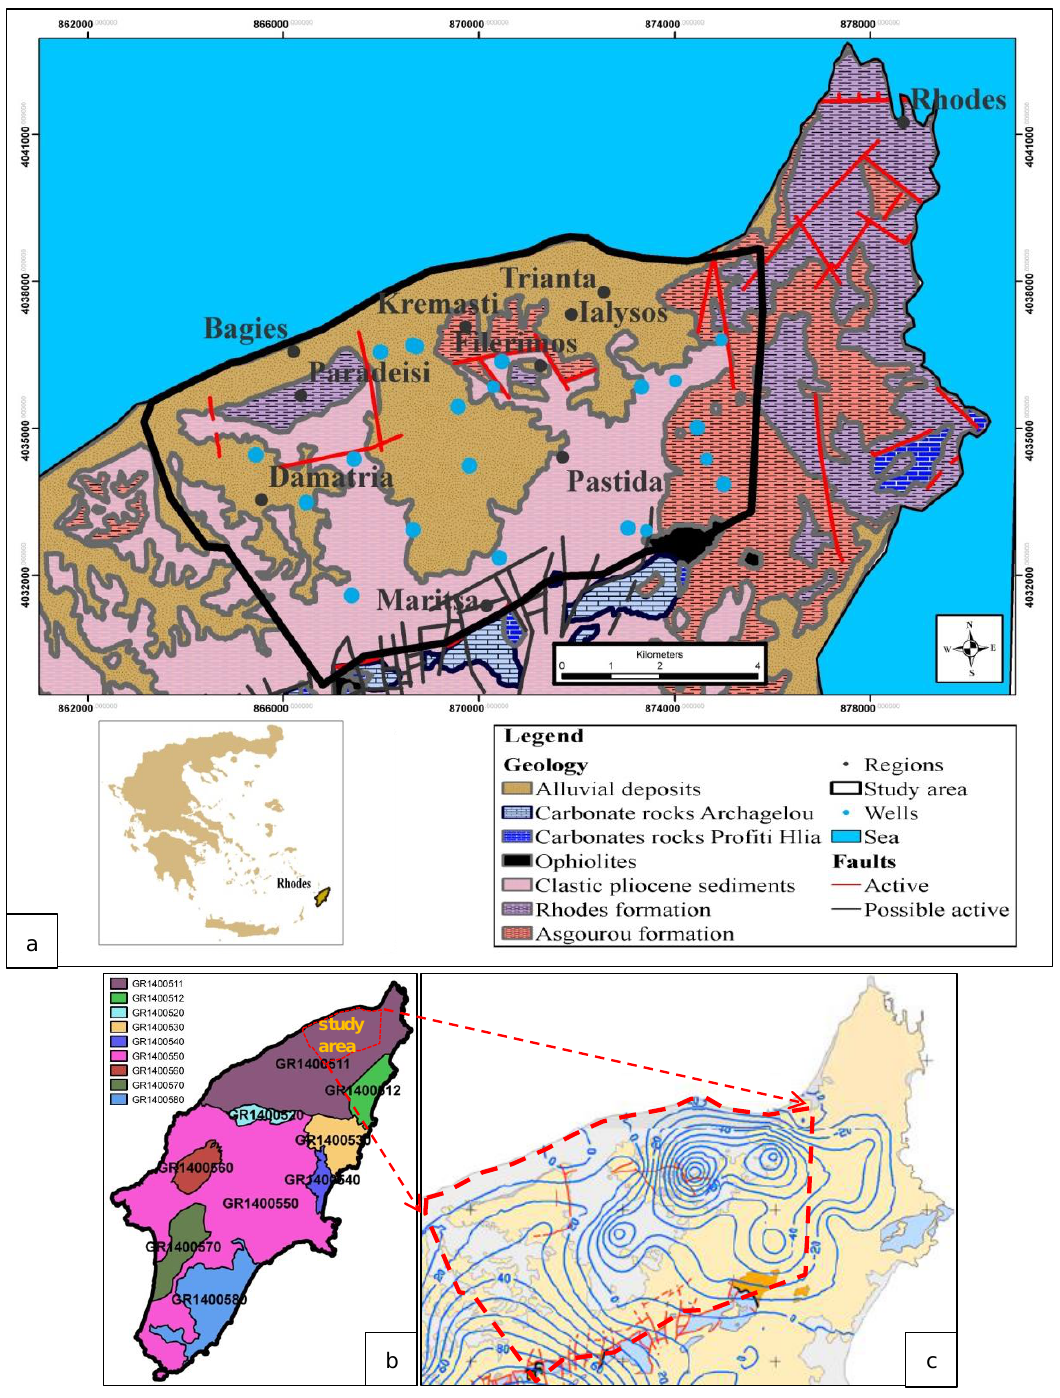
Figure 1. ( a ) Geological map of the wider study area. ( b ) Aquifer systems of Rhodes Island ([31], modified) and study area. ( c ) Piezometric map (September 2008) of the studied aquifer in North Rhodes Island ([26], modified).